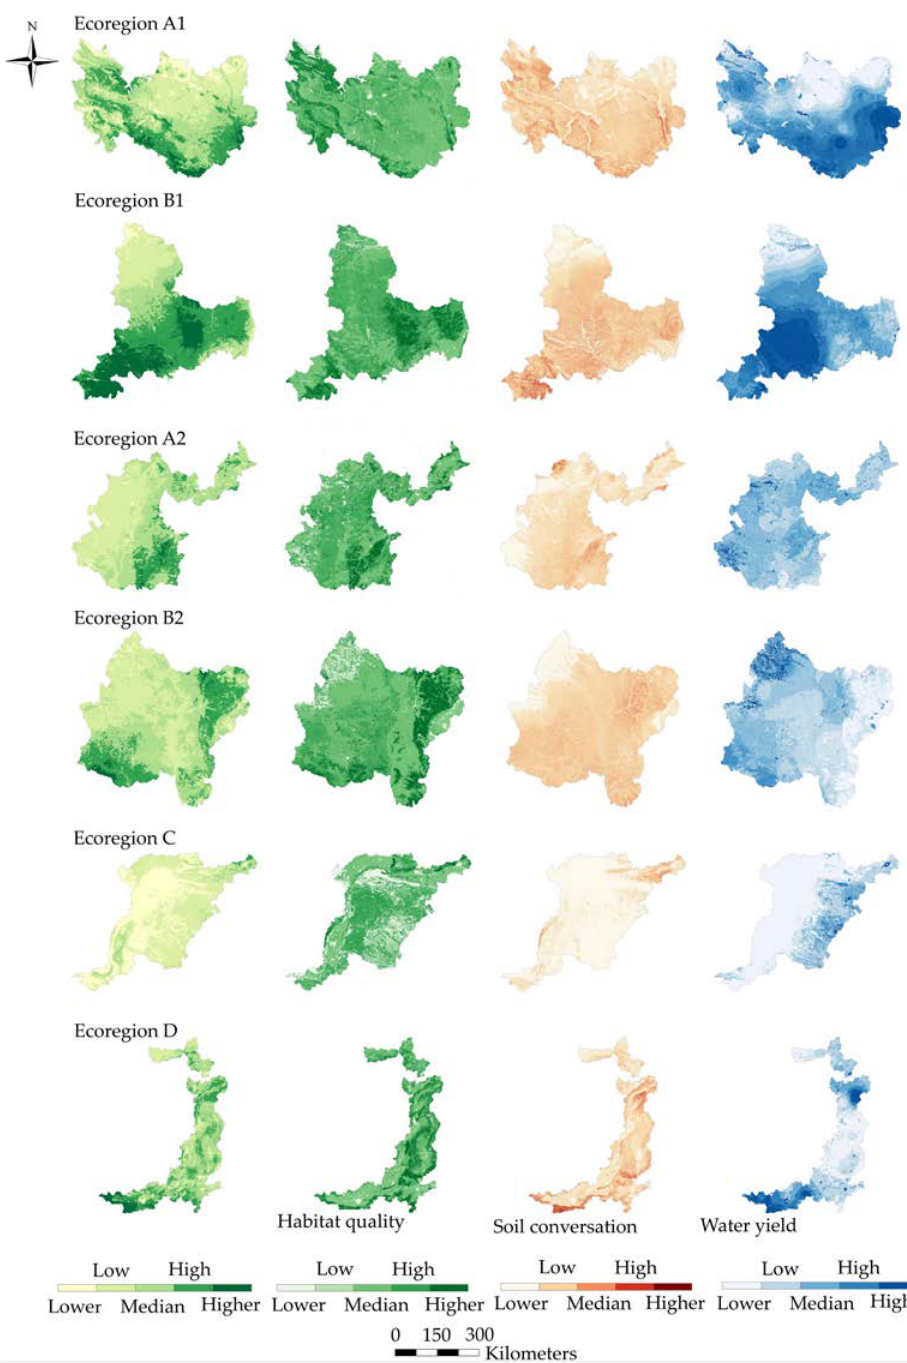
Figure 3. Spatial distribution pattern of ecosystem services on the Loess Plateau. Landscape indices for different sizes of ecological land are shown in Figure 4. Based on the change characteristics, when the landscape size of ecoregions A1, A2, B1, B2, D, and the Loess Plateau as a whole were >400 m, and the landscape size of ecoregion C was >600 m, all the landscape indices tended to be stable and optimal. After merging and deleting small and fragmented patches of ecological land, the landscape connectivity of ecological lands was